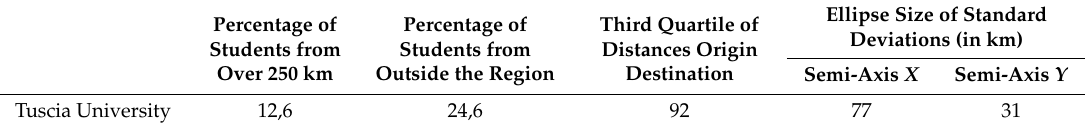
Ellipse Size of Standard Deviations (in